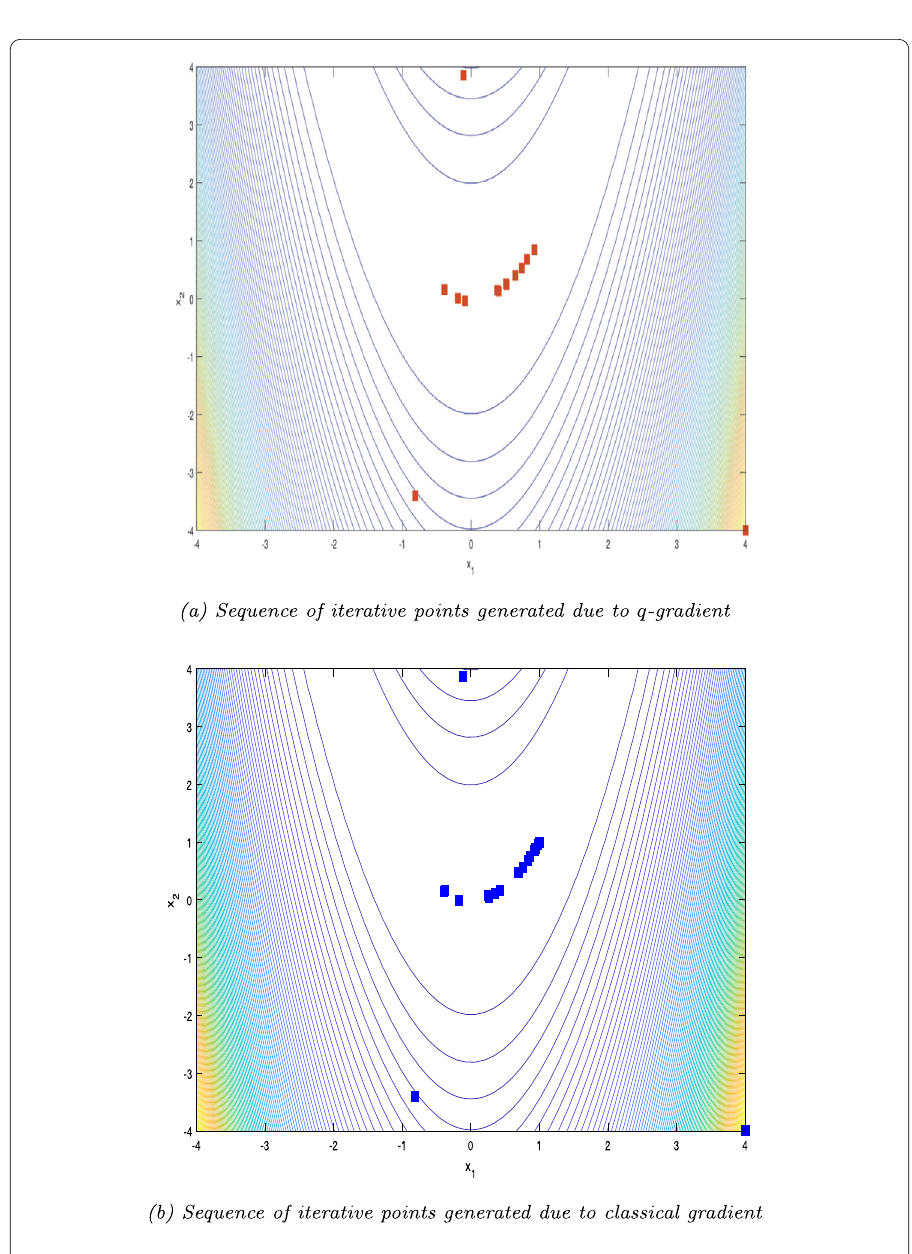
Figure 3 Comparison of Algorithm 1 with [23] on Example 4